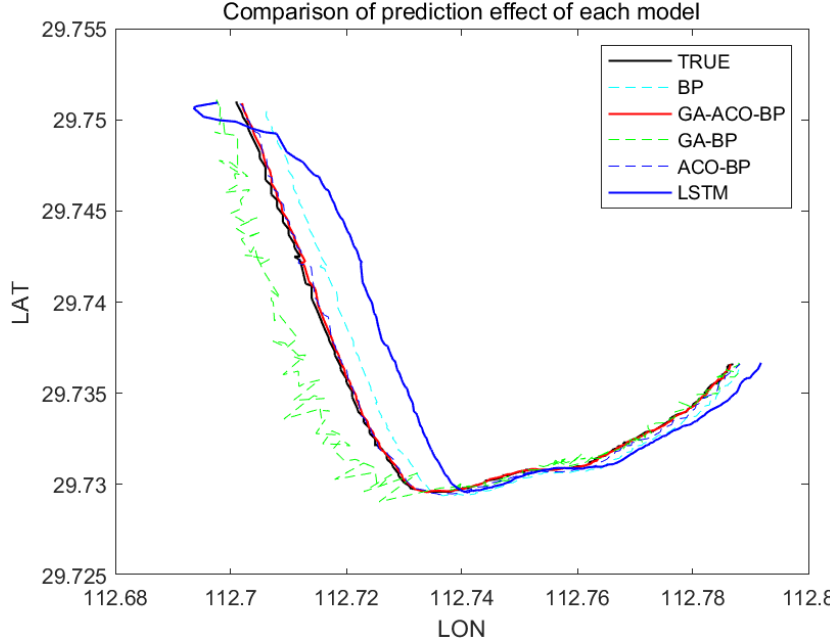
Figure 12. Comparison of track prediction effects of each model (YueYang section).